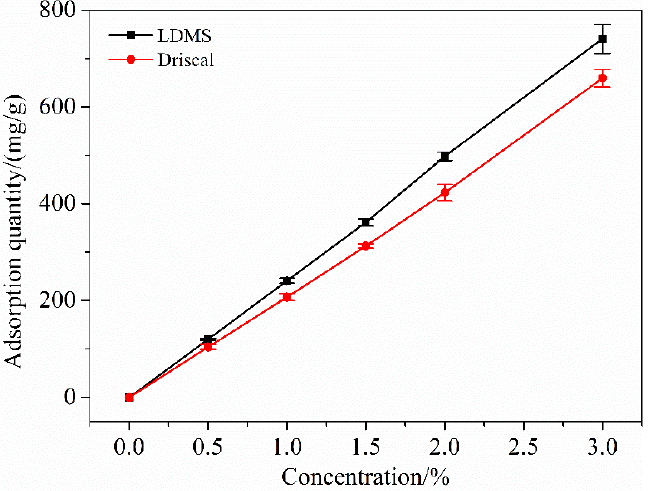
Figure 11. Adsorption quantity of the filtrate reducer on bentonite.